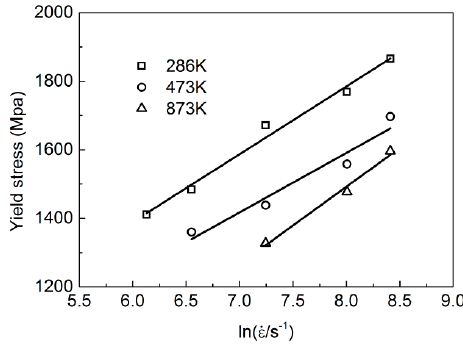
Figure 8. Effect of strain rate (460 – 4500 s −1 ) on yield stress ( 𝜀 𝑝 = 0.002 ) at different ambient temperature.